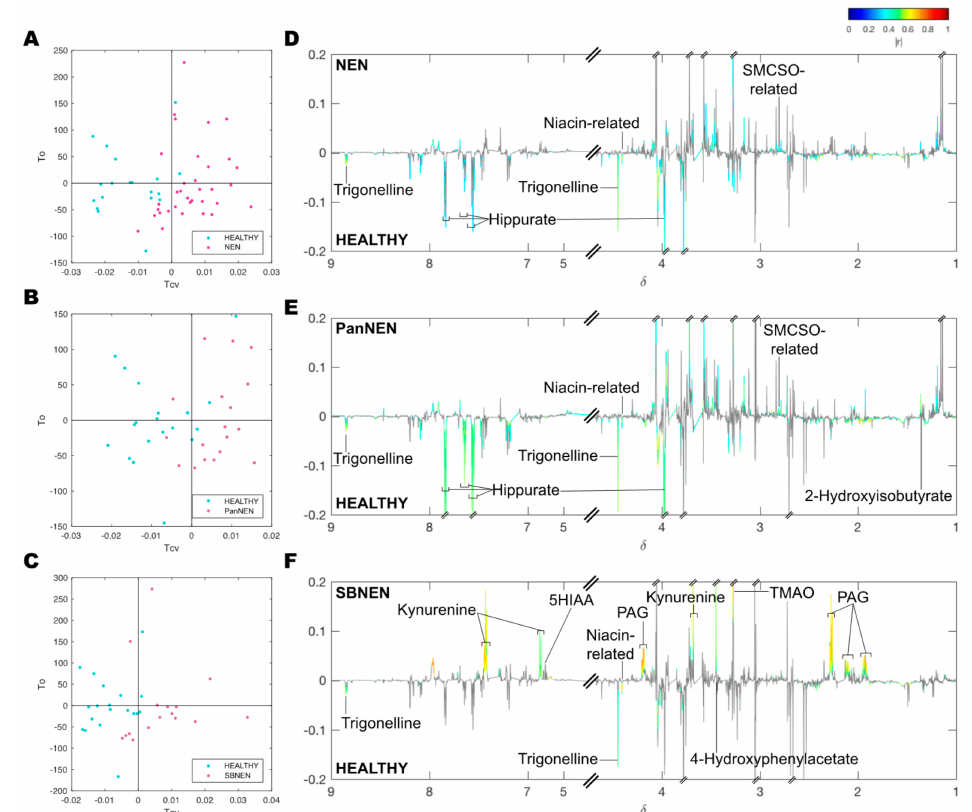
Figure 3. OPLS-DA models comparing NEN and its subgroups to healthy control samples. Scores ( A – C ) and their respective loadings ( D – F ) plots of the model comparing healthy individuals versus all NEN patients ( A , D ), healthy individuals versus those with PanNEN ( B , E ) and healthy individuals versus those with SBNEN ( C , F ). The pseudospectra of the loadings plots are coloured according to correlation coefficient | r | for peak positions where positive false discovery rate ( p FDR) <